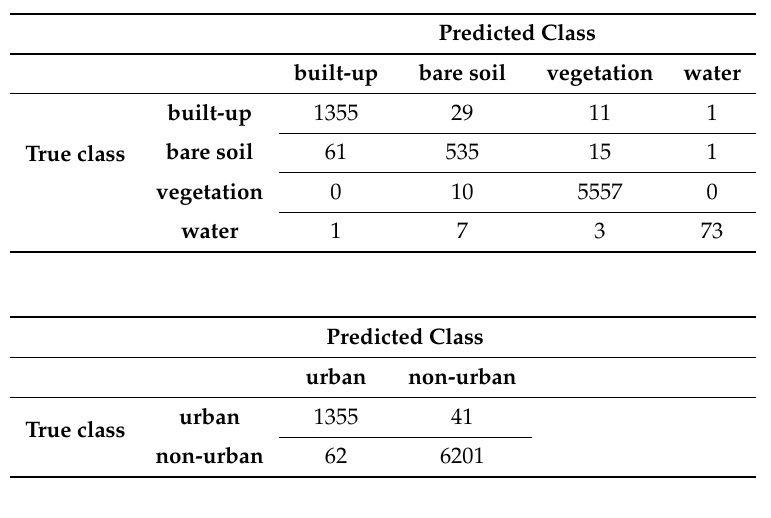
Table 4. Confusion matrices for the classification process of Landsat images in Rionegro. The top table corresponds to the initial classification process of pixels into four categories and the bottom table corresponds to the final re-classification process into two